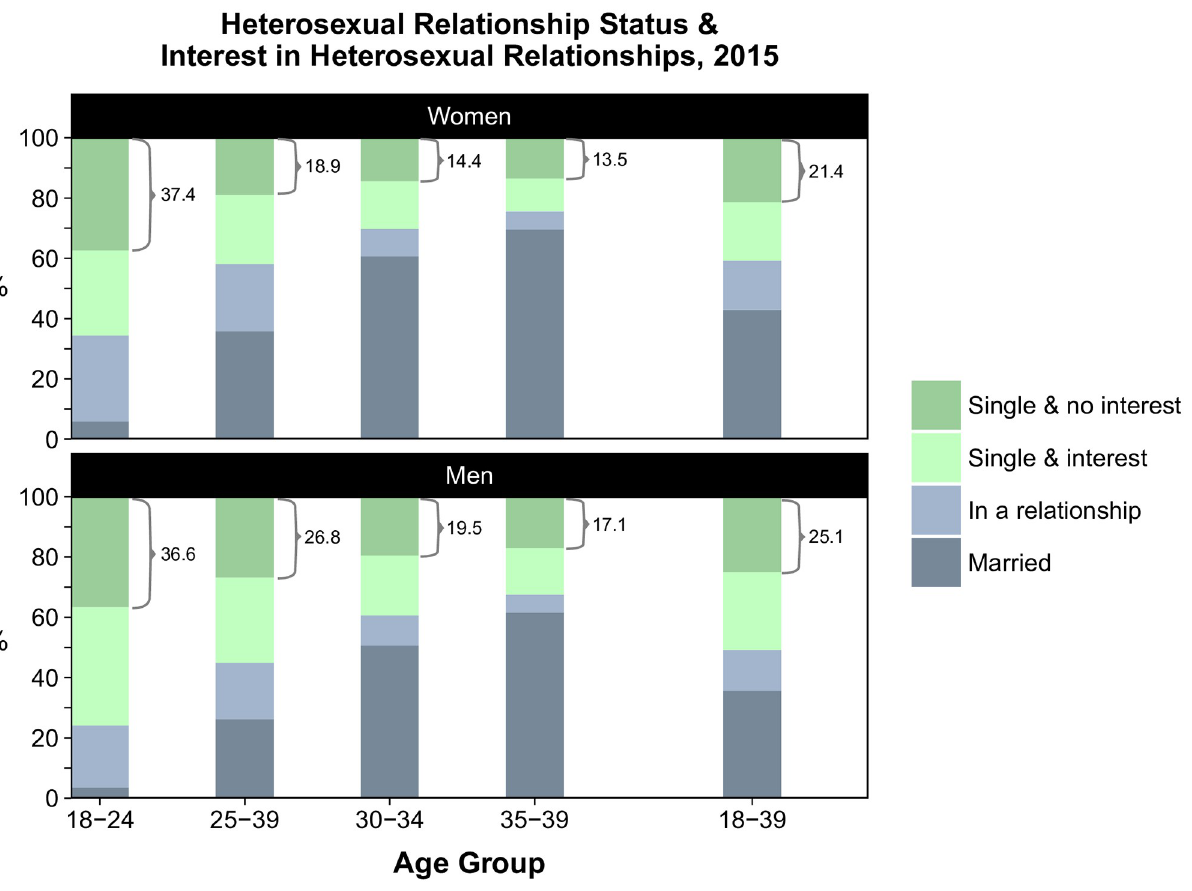
Fig 3. Heterosexual relationship status and interest in heterosexual romantic relationships by age group among women and men in 2015.